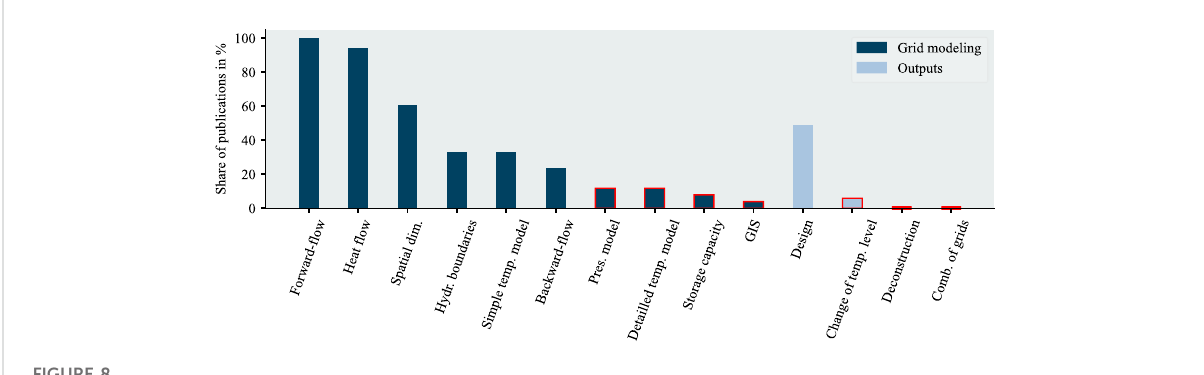
FIGURE 8 Literature distribution for the supercategory grid and the sublevels grid modeling and output; low numbers of publications ( < 15%) are marked red as an indication of a potential research